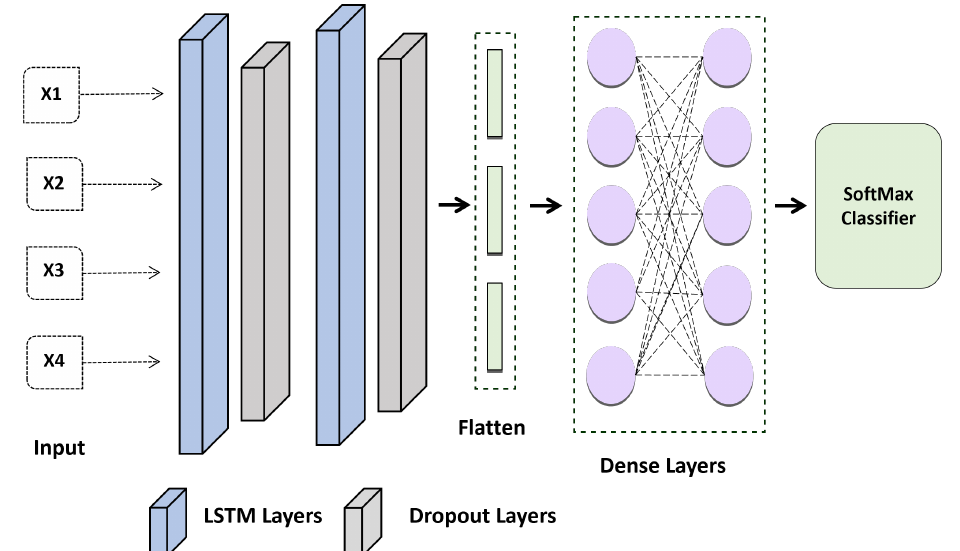
Figure 6. Proposed LSTM Model for ECG-based Authentication.